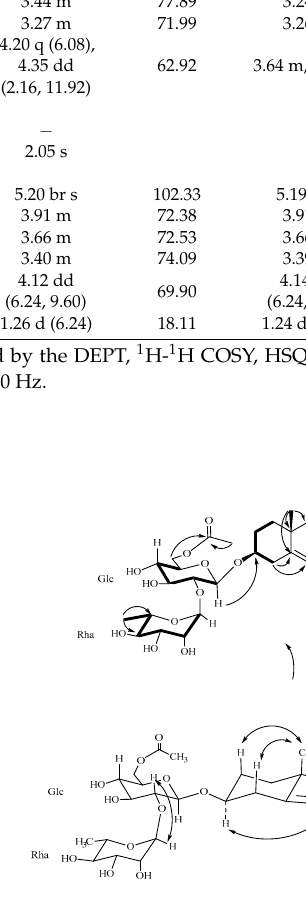
Figure 2. Key 1 H- 1 H COSY, HMBC and NOESY correlations of Compound 1 . Pavitnoside B ( 2 ), white amorphous solid, was positive to Liebermann–Burchard and Molisch chemical reactions. The HR-ESI-MS showed a pseudomolecular ion peak at m/z 777.4044 [M + Na] + (calcd. for C 39 H 62 O 14 Na, 777.4037), corresponding to the molecular formula of C 39 H 62 O 14 , corroborated by analysis of 13 C-NMR and DEPT spectral data. In 1 H-NMR spectrum of 2 , three methyl signals were observed at δ H 0.86 (3H, s, H-18), 1.06 (3H, s, H-19) and 0.79 (3H, d, J = 6.4 Hz, H-27) as well as one olefinic methine proton at δ H 5.39 (1H, br s, H-6). The 13 C-NMR spectrum of 2 exhibited corresponding carbon signals at δ C 17.34 (C-18), 19.99 (C-19) and 17.62 (C-27), one trisubstituted double bonds at δ C 142.06 (C-5) and 122.75 (C-6). Compared to 1 , one angular methyl at δ C 9.26 (C-21) was absent and the chemical shift of C-20 ( δ C 53.15) was up-field ( Δ δ C + 7.47 ppm), which indicated that a hydroxyl group substituted at the C-21 primary carbon atom. It was evidenced by 1 H- 1 H COSY correlations between H-20 ( δ H 2.25, dd, J = 5.84, 8.56 Hz) and H-21 [ δ H 3.61 (m), 3.80 (m)] and by HMBC cross-peaks between H-21 ( δ H 3.61, 3.80) and C-20 ( δ C 53.15)/C-22 ( δ C